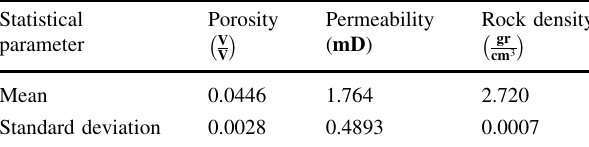
Table 4 Statistical analysis of core data in well